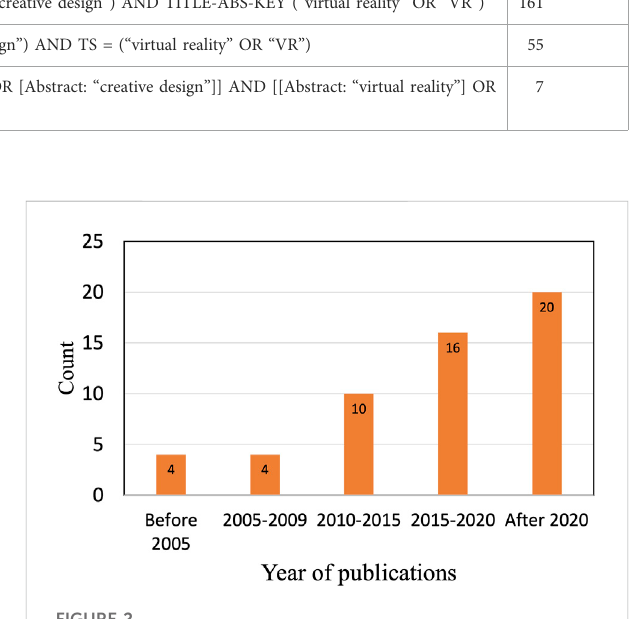
FIGURE 2 Count of publications by year since before 2005 to after